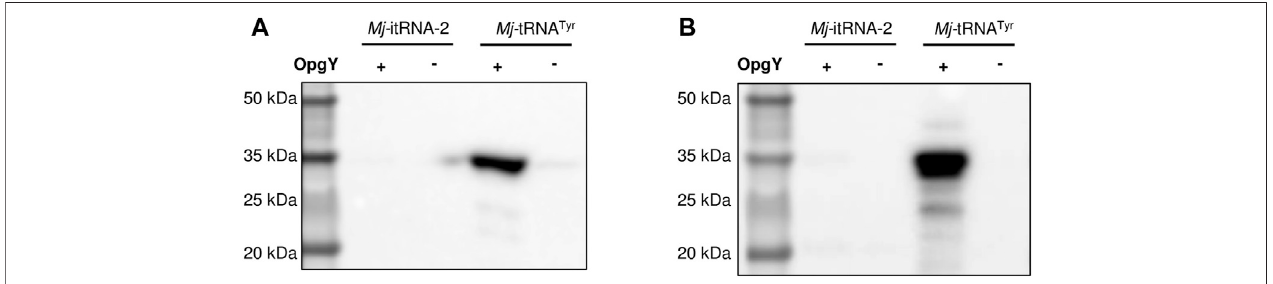
FIGURE 4 | Suppression of an elongational TAG codon with Mj -itRNA-2. There is a TAG codon between GST and the Z domain-His 6 , and the fusion protein was expressedwith Mj -itRNA-2or Mj -tRNA Tyr